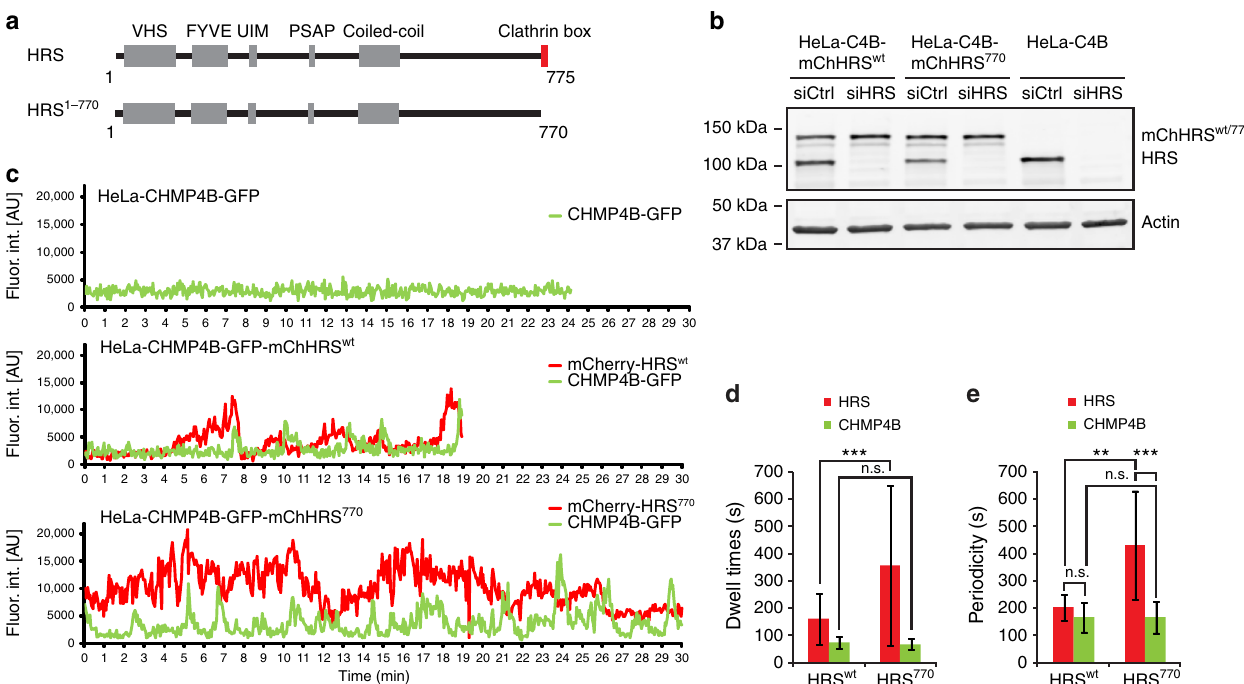
Fig. 5 Absence of endosomal clathrin leads to hyperstabilization of HRS on endosomes. a Domain structure of HRS and the HRS mutant HRS 770 lacking the clathrin-binding domain. b WB showing depletion of endogenous HRS and expression levels of siRNA-resistant mCherry-HRS wt or mCherry-HRS 770 in the background of the HeLa-CHMP4B-GFP cell line ( “ C4B ” ). c HeLa cells stably expressing CHMP4B-GFP alone or in combination with mCherry-HRS wt or -HRS 770 were depleted for endogenous HRS by siRNA as shown in Fig. 5b. Live-cell imaging and fl uorescence intensity pro fi les of tracked EGF-positive endosomes over time. Representative examples of 13 (HRS wt ), 12 (HRS 770 ) and 8 (no HRS) tracks from ≥ 3 independent experiments. d Dwell times for individual mCherry-HRS or CHMP4B-GFP waves were quanti fi ed manually in a blinded way. HRS wt : 62 (HRS) and 55 (CHMP4B) waves, HRS 770 : 29 (HRS 770 ) and 83 (CHMP4B) waves from the dataset described in c . Error bars indicate SD. t -test, *** p < 0.001, n.s. not signi fi cant. e Periodicities for mCherry-HRS or CHMP4B-GFP waves were quanti fi ed manually in a blinded way. Only tracks covering at least 200 frames were included. HRS wt : 11 tracks, HRS 770 : 11 tracks from the dataset described in c . Error bars indicate SD. t -test, ** p < 0.01, *** p < 0.001, n.s. not statistically signi fi